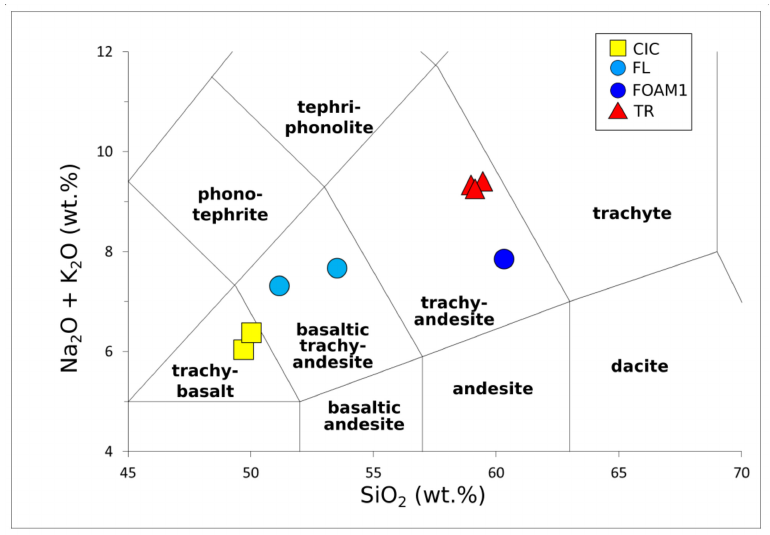
Figure 4. Total alkali vs. silica diagram showing the composition of selected samples from the investigated